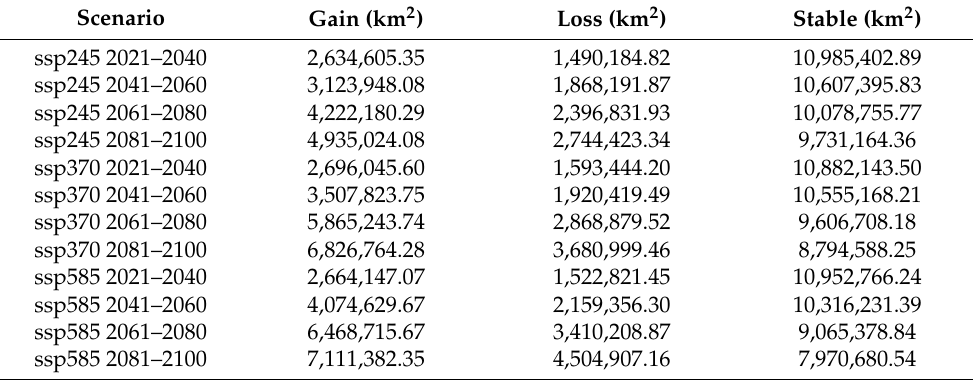
Table 1. Losses and gains of the species under different